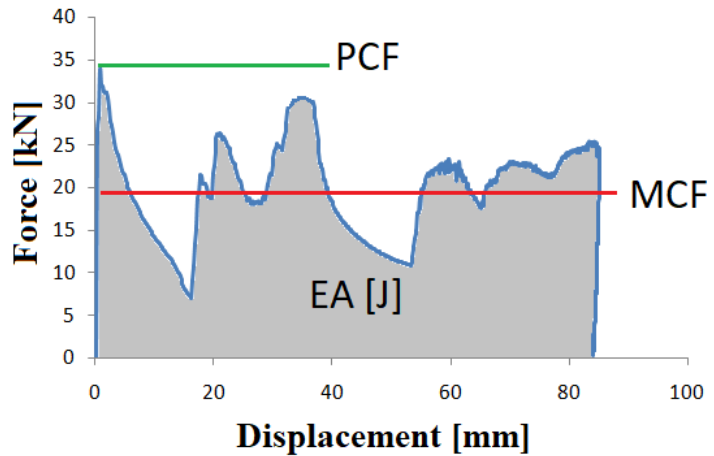
Figure 1. Example of force-displacement characteristics of an energy absorber.